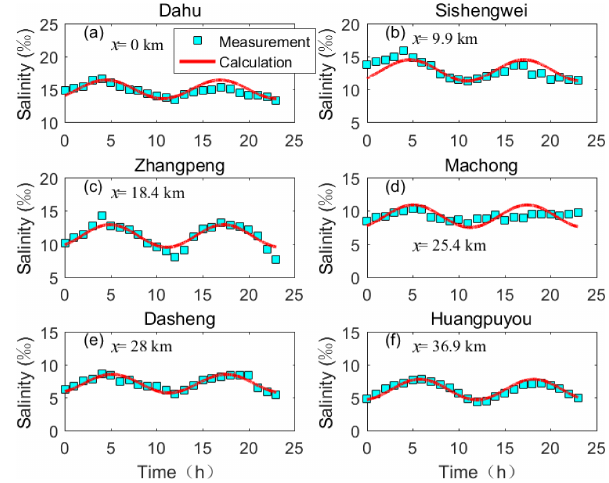
Figure 6. Comparison between the predicted and measured salinity concentration over time on 31 January (neap tide) at each study site, showing that the analytical model captures the temporal variation in salinity. The hourly salinity measurements are represented by rect- angles, while the simulated salinity varying with time is represented by the red solid line. In the figure, x is the distance from the estuary